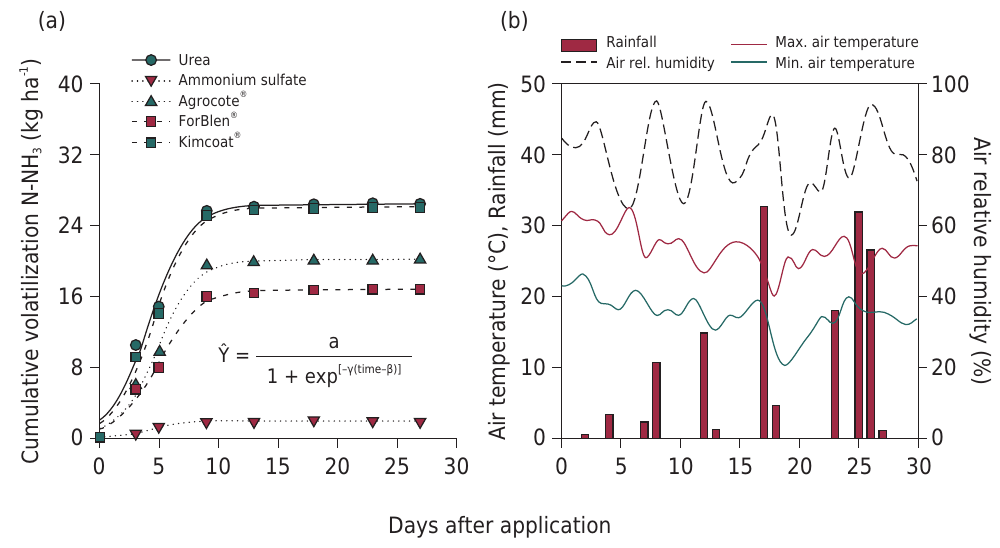
Figure 3. Cumulative volatilization N-NH 3 (a) and climatic conditions (b), after broadcast applications of urea, ammonium sulfate, and